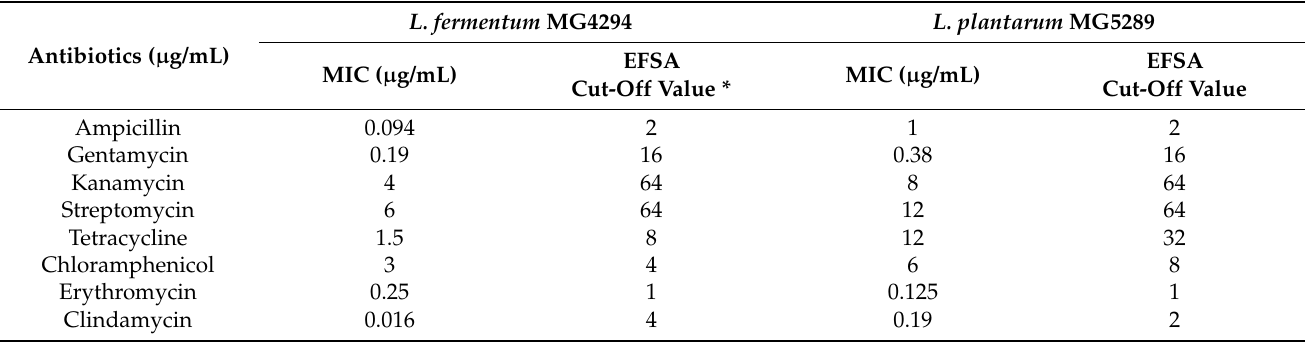
Table 1. Minimum inhibitory concentrations (MIC) of antibiotics of L. fermentum MG4294 and